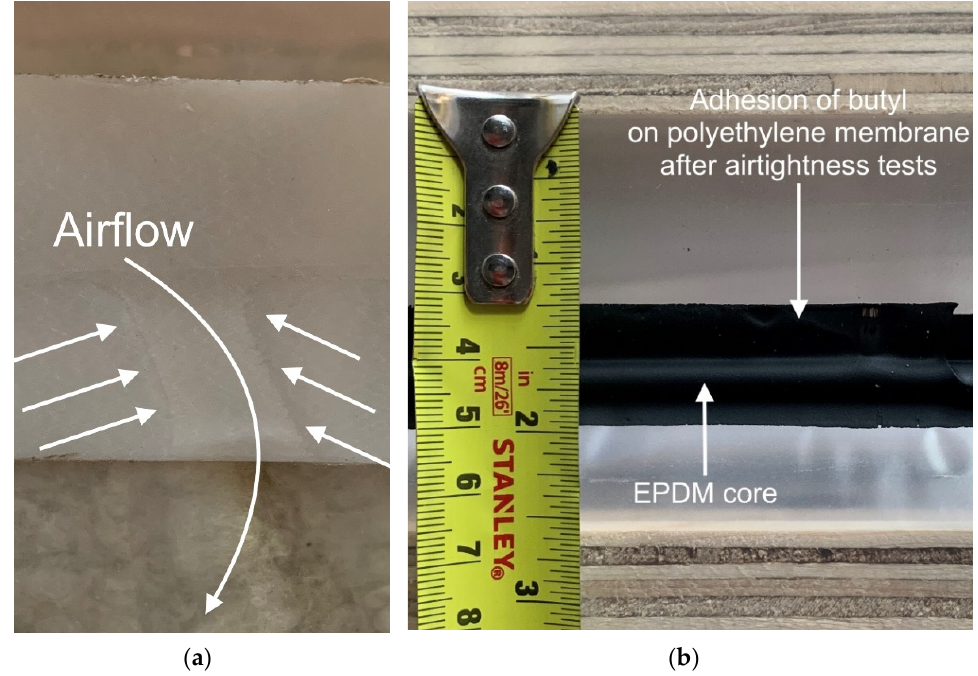
Figure 14. Air channels found within sheathing tape installed on a non-rigid surface ( a ) and the strong adhesion of butyl on polyethylene membranes ( b ).